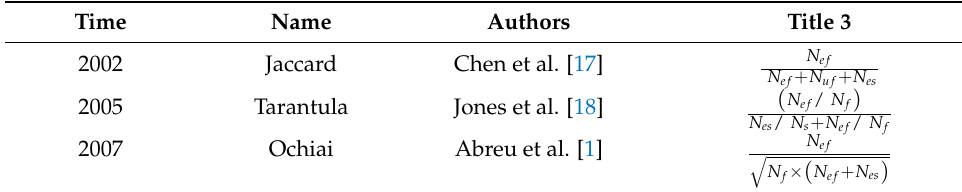
Table 1. Spectrum-based fault